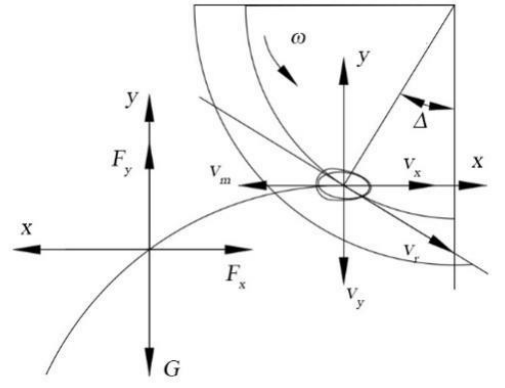
Figure 12. Velocity and force analysis diagram for the seed unloading area: v x is the horizontal absolute speed, m/s; v y is the vertical absolute speed, m/s; v m is the forward speed of the machine, m/s; v r is the linear speed at the suction hole of the seed discharge disc, m/s; F x is the external resistance on the x -axis, N; and F y is the external resistance on the y- axis, N.